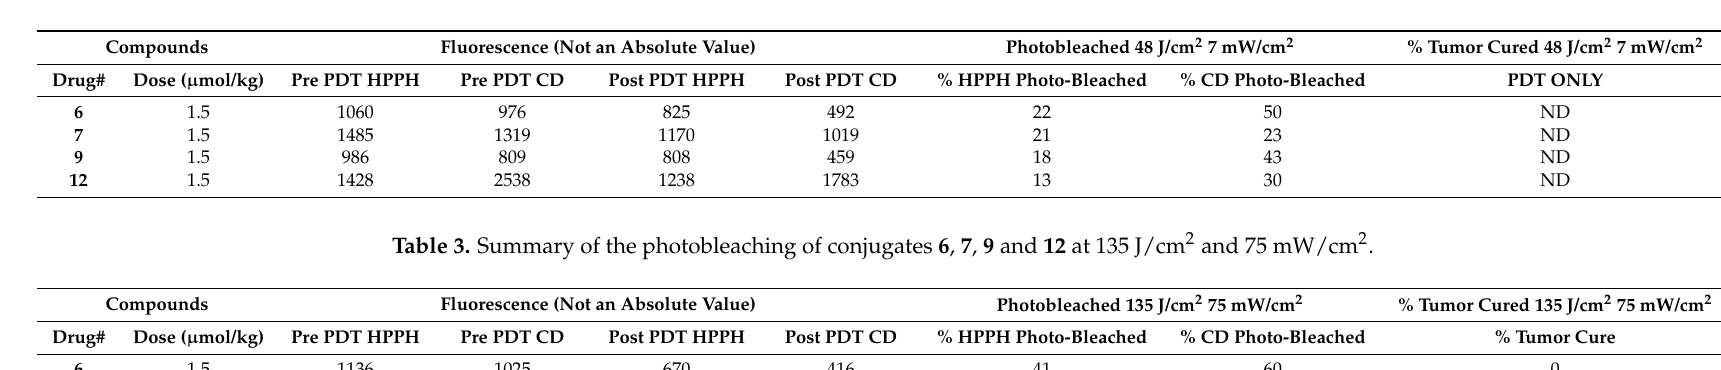
Table 2. Summary of the photobleaching results with conjugates 6 , 7 , 9 and 12 at a light dose of 48 J/cm 2 and 7 mW/cm 2 . The PDT activity of the conjugates at a light dose of 48J/cm 2 , 7 mW/cm 2 was not determined (ND).